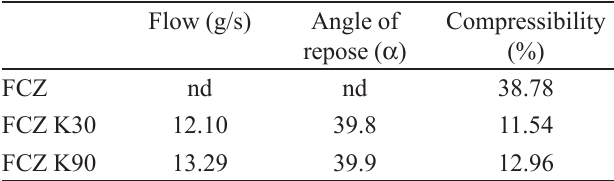
TABLE II - Flowability characteristics of fluconazole (FCZ) and fluconazole granules produced with Plasdone ® K29/32